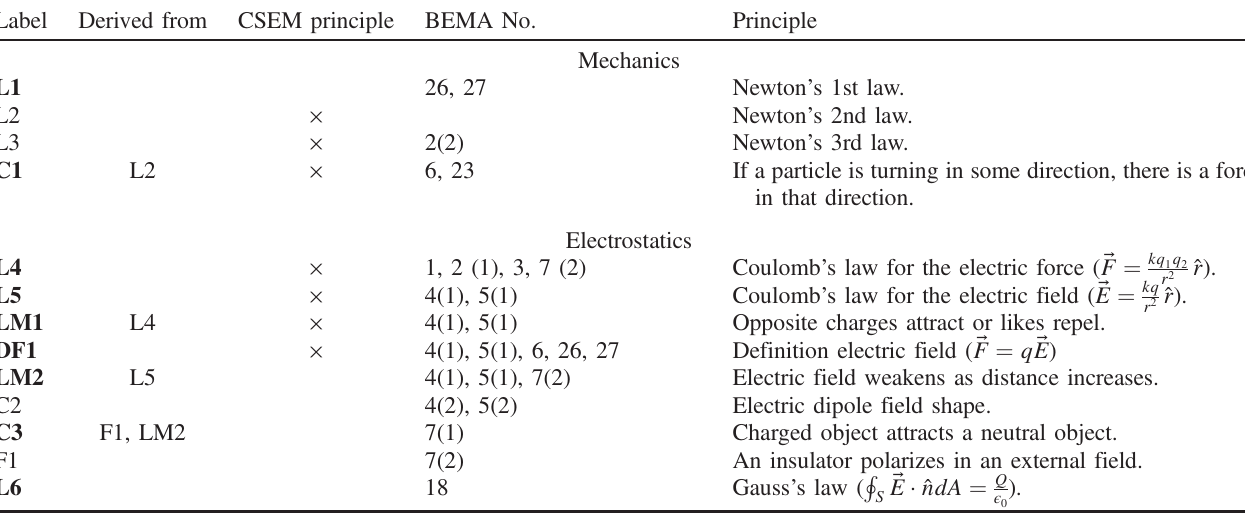
TABLE III. Theoretical model tested by the BEMA. An × indicates that the principle is used in the CSEM. Label Derived from